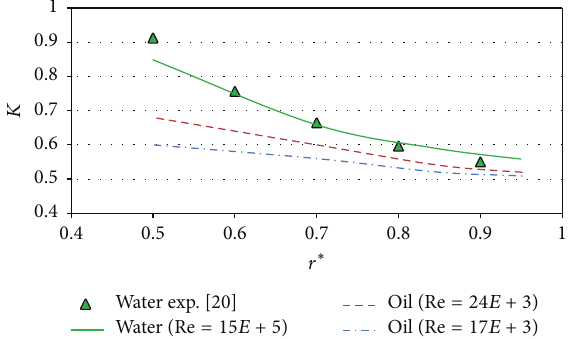
Figure 12: Effect of Reynolds number on dimensionless fluid rotational angular velocity.